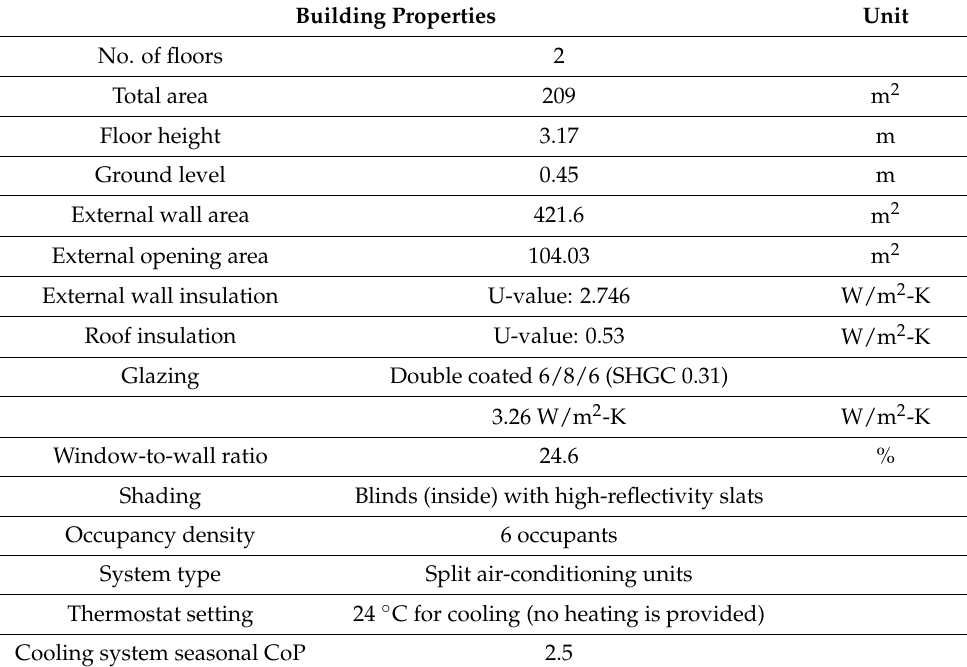
Table 2. Simulation inputs for the building’s properties.